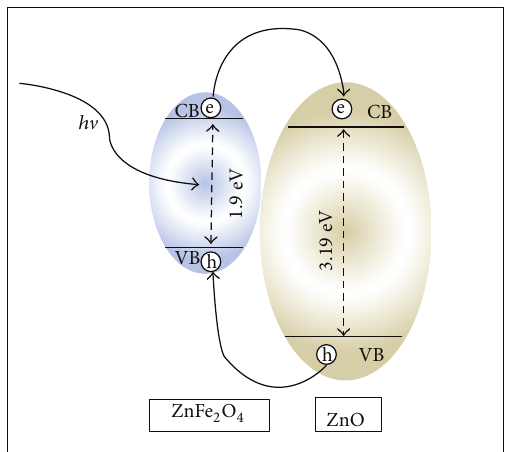
Figure 4: Scheme of the coupling action of different energy bands between ZnO and ZnFe 2 O 4 [17].